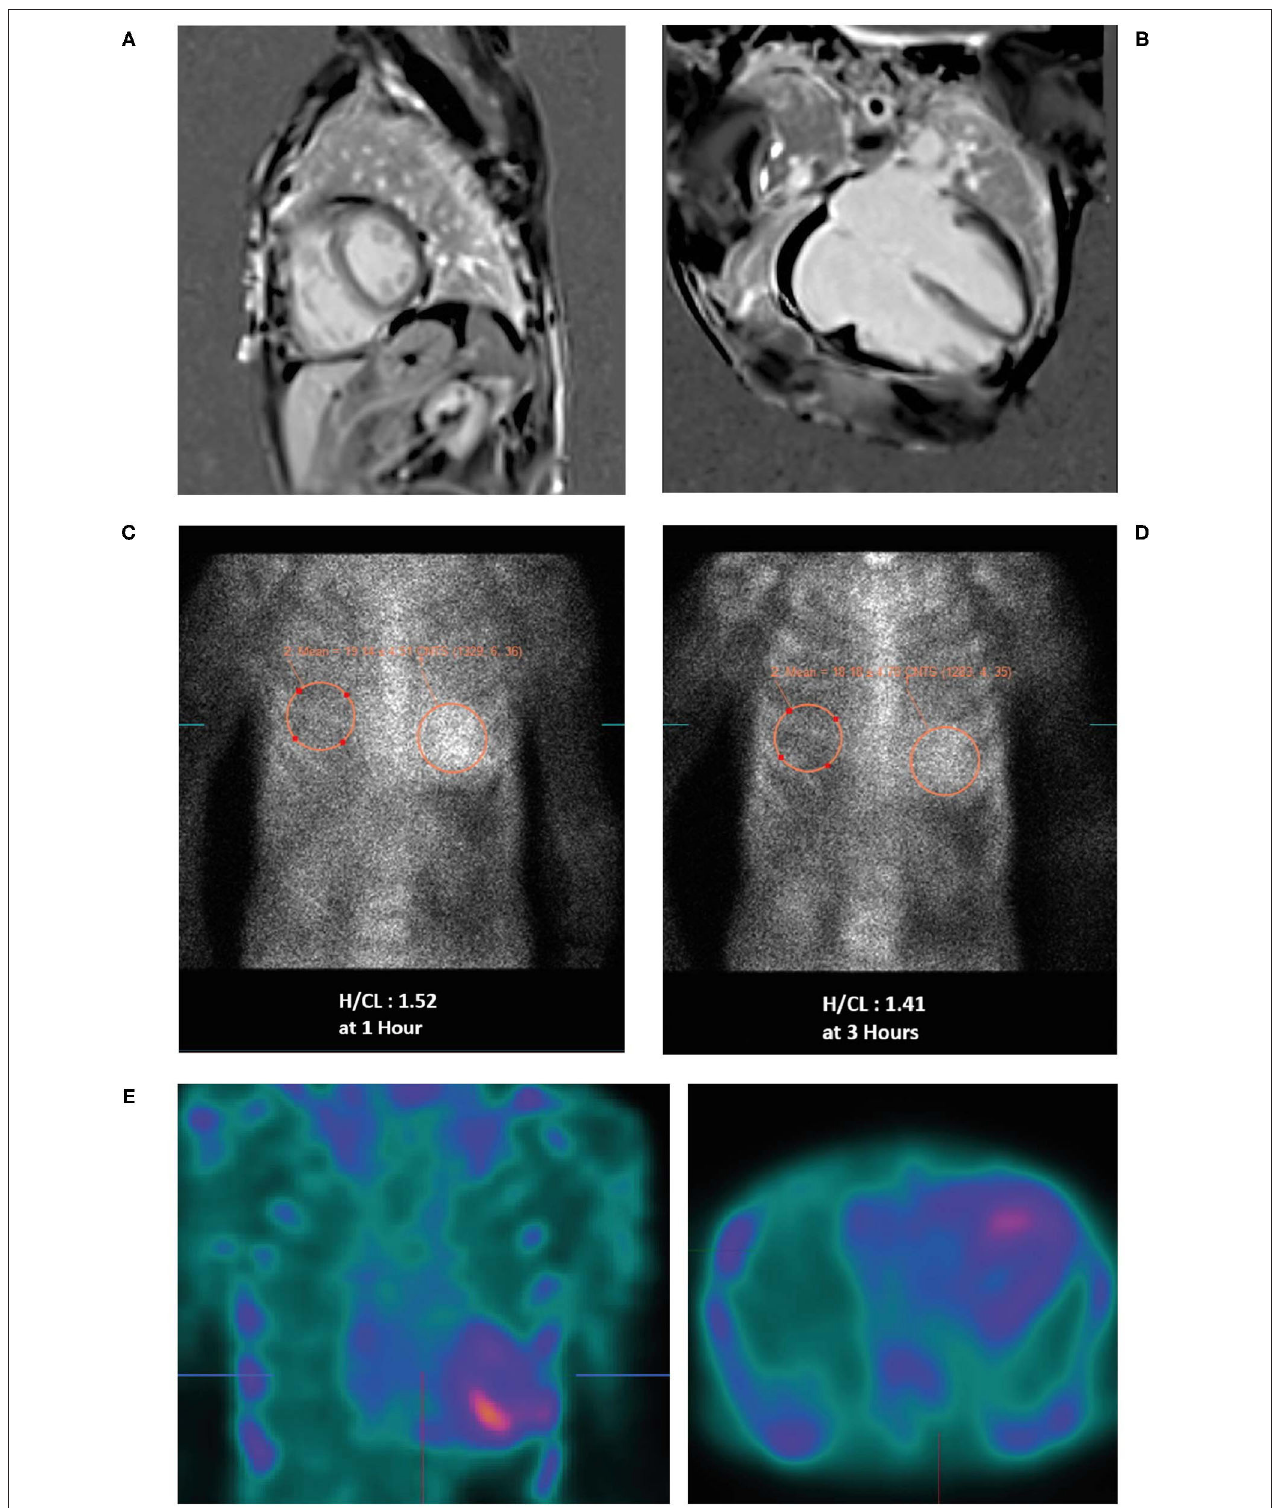
FIGURE 4 | Cardiac MRI (A,B) showing biatrial enlargement without evidence of infiltrative disease. Planar bone scintigraphy ( 99m Tc-PYP) at 1h (C) and 3h (D) showing myocardial PYP uptake greater than rib uptake (grade 3) via semi-quantitative assessment—strongly suggestive of ATTR-CM. SPECT scan (E) at 1h showing no blood pool. 99m Tc-PYP, 99m technetium-labeled pyrophosphate; ATTR-CM, transthyretin amyloid cardiomyopathy; MRI, magnetic resonance imaging; PYP, pyrophosphate; SPECT, single-photon emission computed tomography.